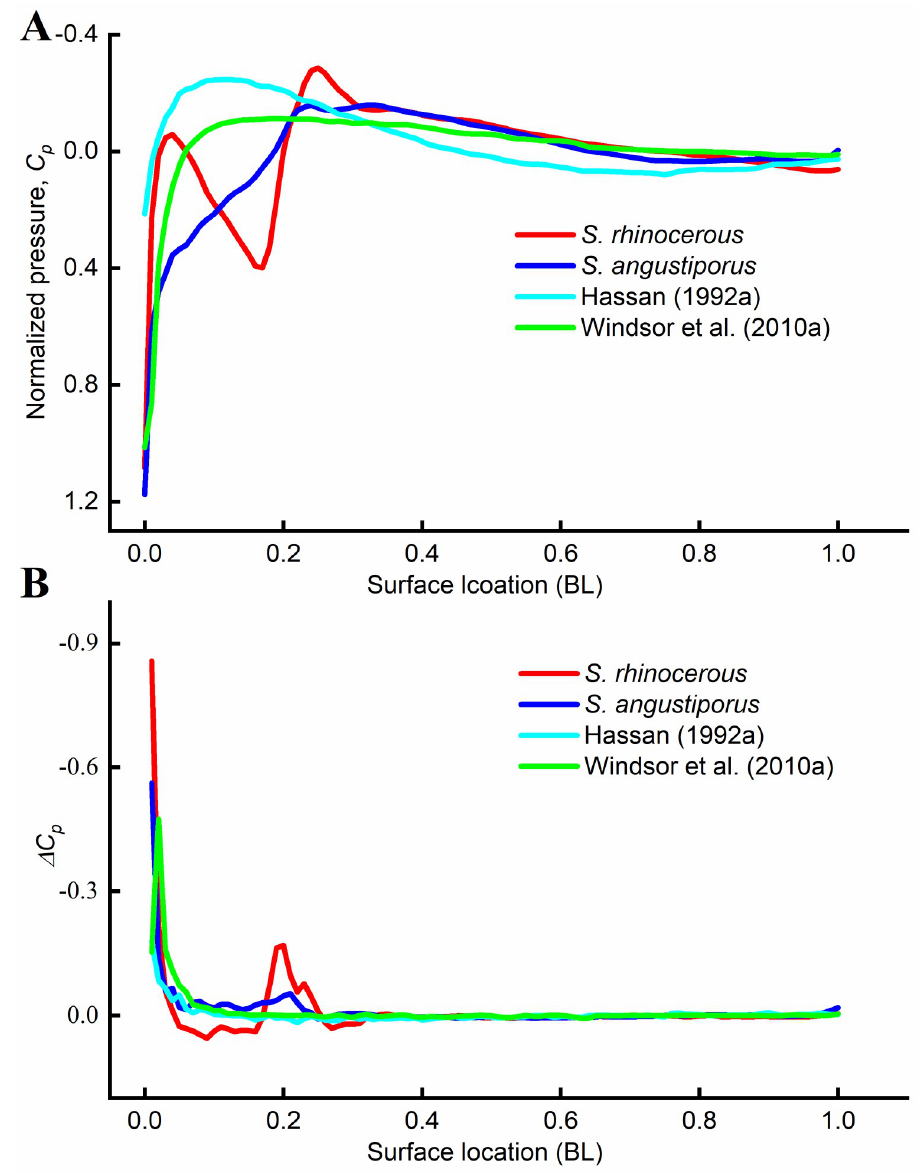
The Y-axis is plotted with its scale reversed (decreasing